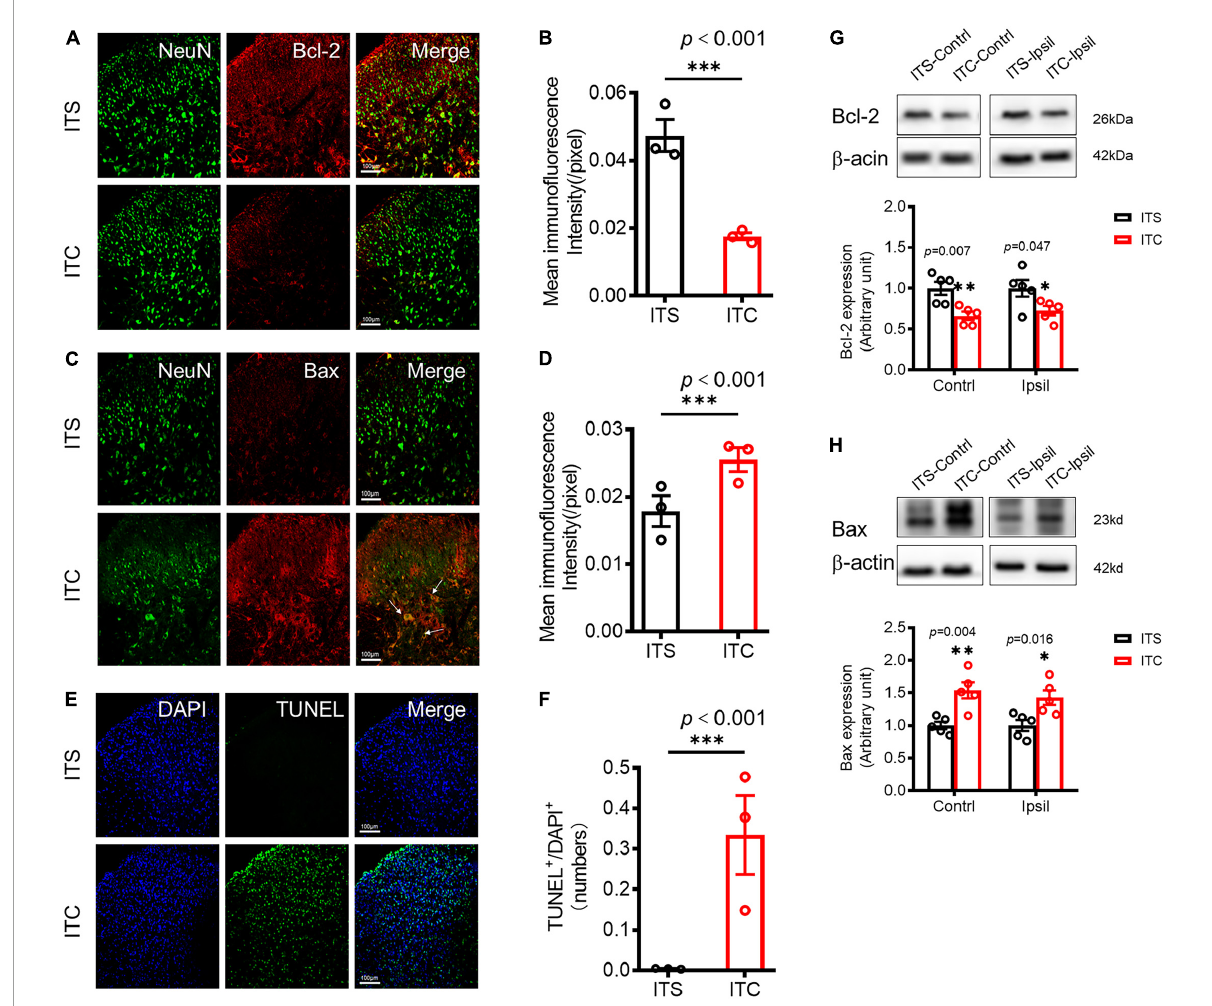
FIGURE4 Retrograde degeneration induced neuronal cell apoptosis of spinal dorsal horn caused by ITC-induced thalamic hemorrhagic stroke. Representative immunofluorescent photomicrographs showing co-localization of NeuN with Bcl-2 (A) and with Bax (C) in the spinal dorsal horn 7 days after ITC. Quantification of the mean immunofluorescent intensity of Bcl-2 (B) and Bax (D) . *** p < 0.001 ITC vs. ITS, n = 3 rats/group. (E) Representative fluorescent photomicrographs of TUNEL- and DAPI-labeled cells. (F) Quantitative data of TUNEL-labeled cells. *** p < 0.001 ITC vs. ITS, n = 3 rats/group. (G) and (H) Western blot assay and quantitative analysis of Bcl-2 (G) and Bax (H) protein expressions in bilateral dorsal cord following 7 days after ITC or ITS. * p < 0.05, ** p < 0.01, ITC vs. ITS, n = 5 rats/group.